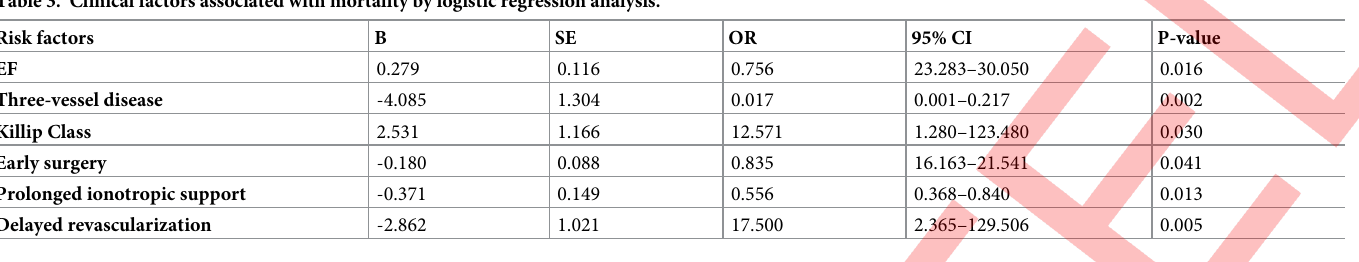
Table 3. Clinical factors associated with mortality by logistic regression